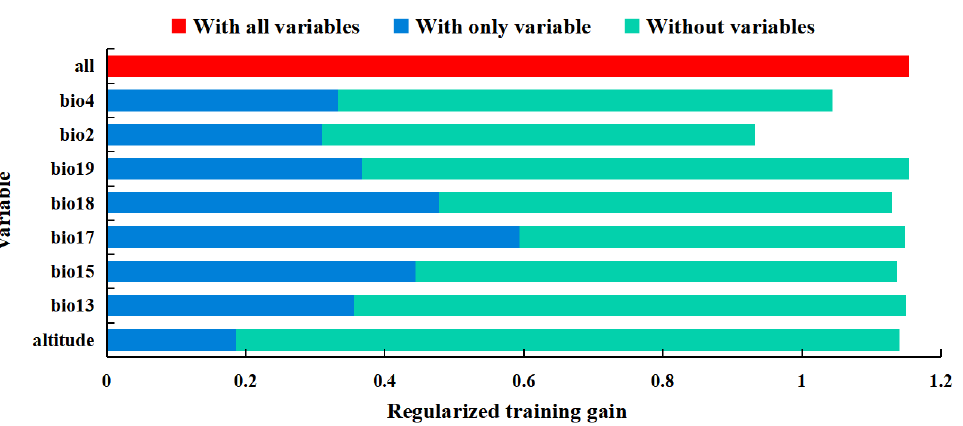
Figure 4. The jackknife method results of environmental variables for Helicoverpa zea .